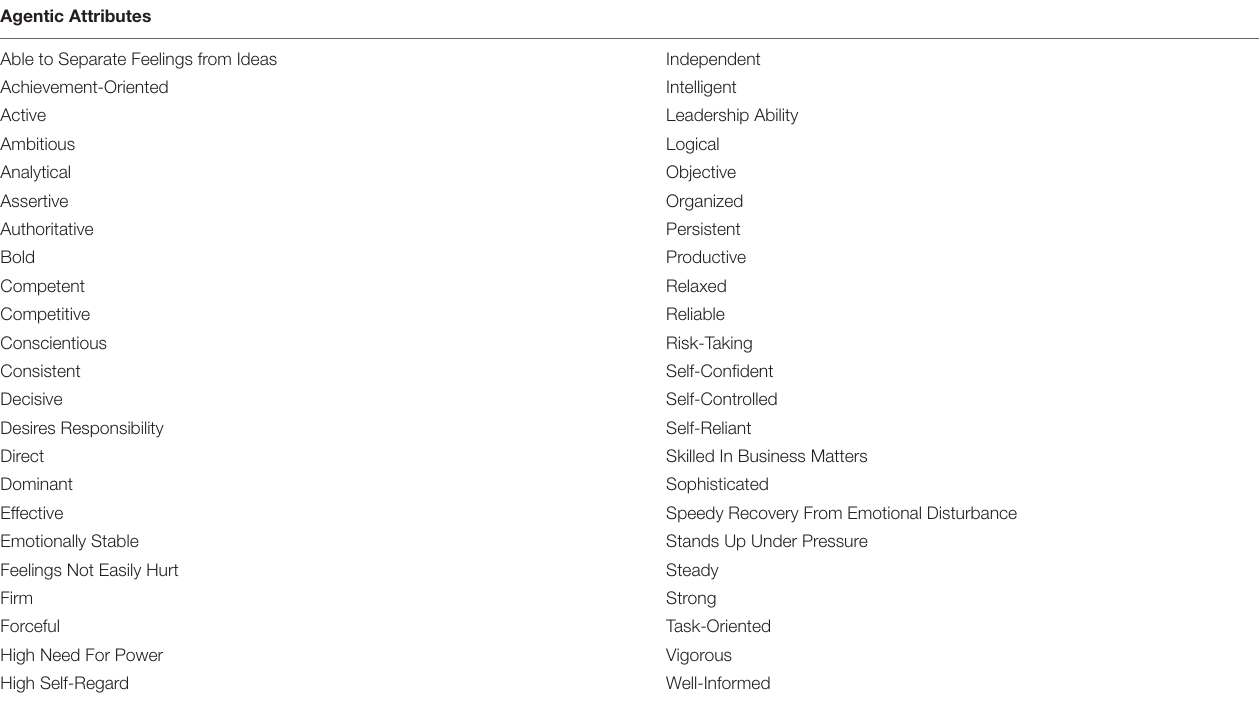
TABLE A | List of agentic attributes measured.